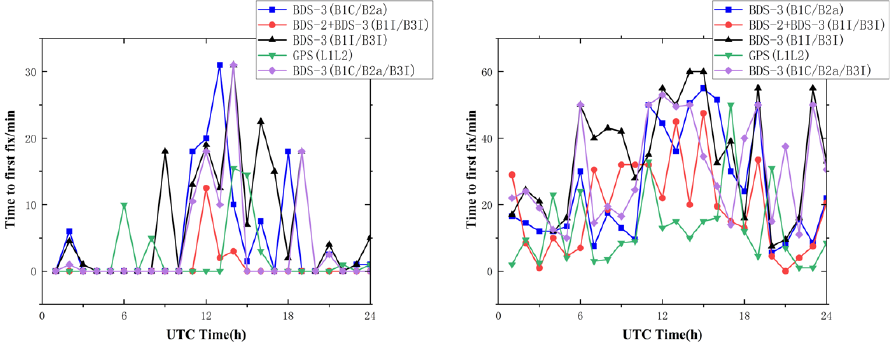
Figure 12. Time to first fix of baseline TGCU – TGBU ( left ); time to first fix of baseline TGCU-TGDA ( right ).